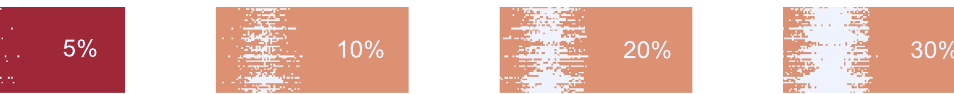
Figure 3. RAR employs SVM to classify the FNCs of the top 5% of the salient input data as estimated by the whole MILC model’s predictions. We used integrated gradients (IG) and smoothgrad integrated gradients (SGIG) to compute feature attributions. It is evident that when an independent classifier (SVM) learned on every subject’s most salient 5% data, the predictive power was significantly higher compared to the same SVM model trained on the randomly chosen same amount of data. In other words, the poor performance with randomly selected data parts indicates that other parts of the data were not exclusively discriminative as the whole MILC estimated salient 5% data parts. We also notice that sample masks over a different percentage of data coverage gradually obscured the localization of the discriminative activity within the data. Though the SVM model gradually became predictive with increased randomly selected data coverage, which we show in Supplementary Information, this performance upgrade was due to the gradual improvement in functional connectivity estimation and not attributable to the disease-specific localized parts within the data. For every disorder (Autism spectrum disorder, Schizophrenia, and Alzheimer’s disease), the higher AUC at this 5% indicates stronger relevance of the salient data parts to the underlying disorders. Furthermore, the RAR results reflect that in most cases, when whole MILC was trained with limited data, the w/ pretraining models estimated feature attributions more accurately than the models w/o